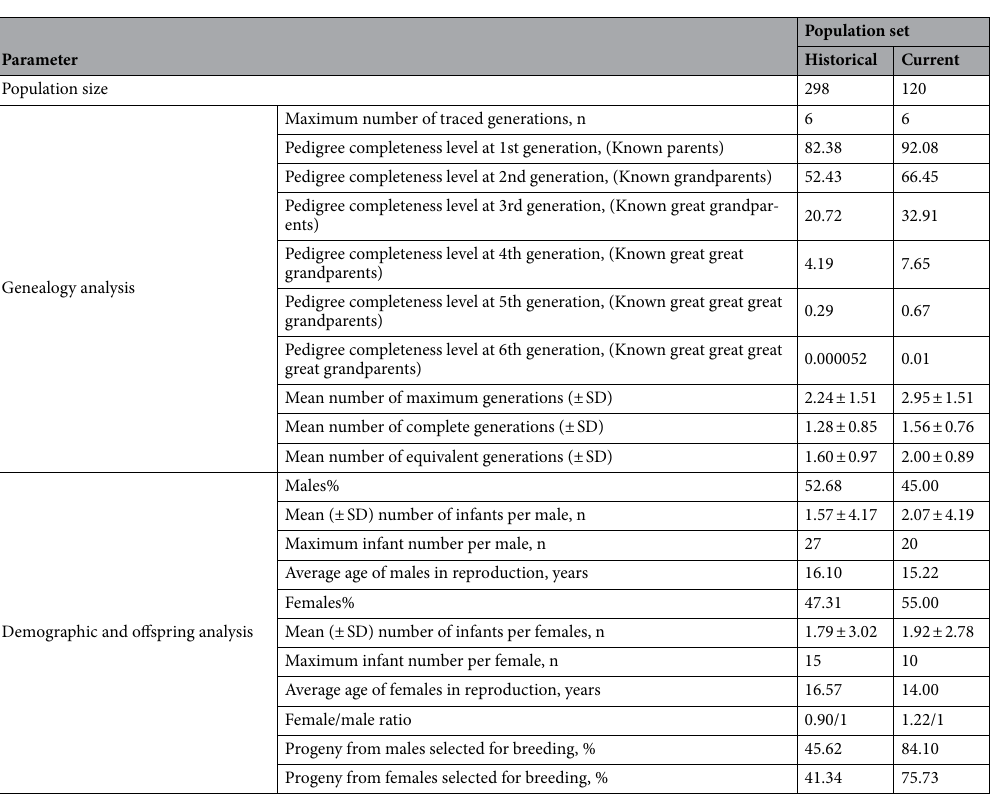
Table 1. Summary of statistics of genealogy, demographic and offspring analysis in the historical and current populations of white-naped mangabey.